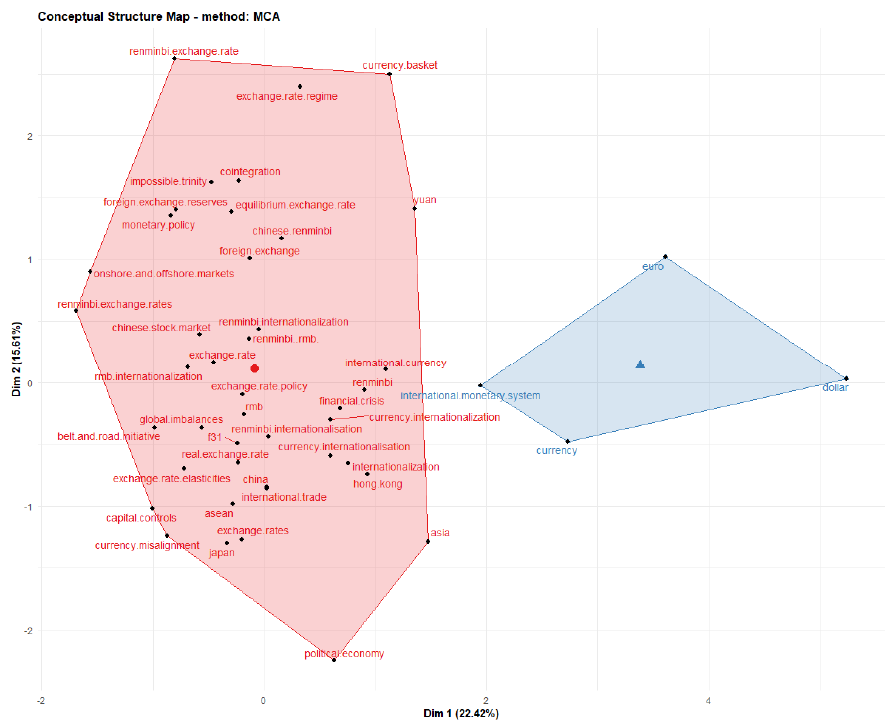
Figure 10. Conceptual map and authors’ keywords clusters. Source: Authors’ elaboration using Bib- lioshiny.